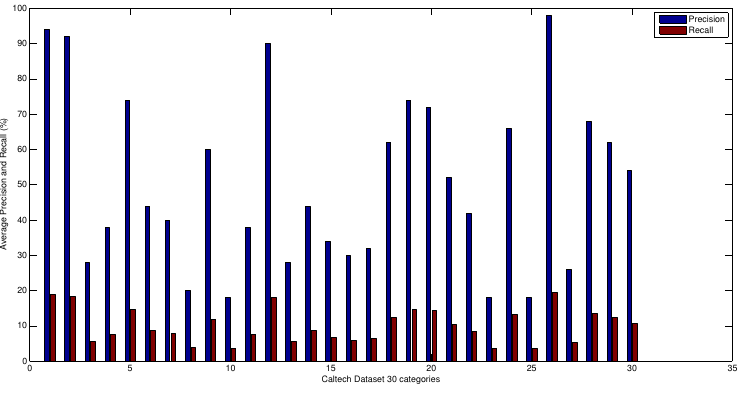
Figure 5. Average precision and recall results of the proposed method over 30 categories of Caltech-101 dataset.